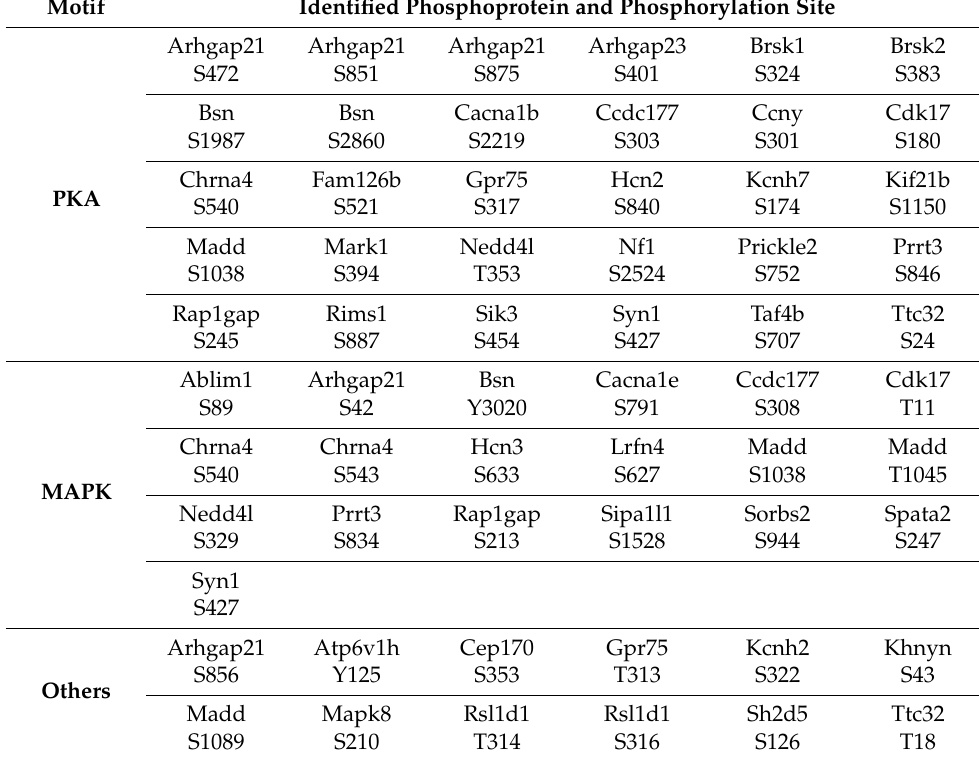
Table 2. List of phosphoproteins along with phosphorylation site downstream of adenosine (A2AR)